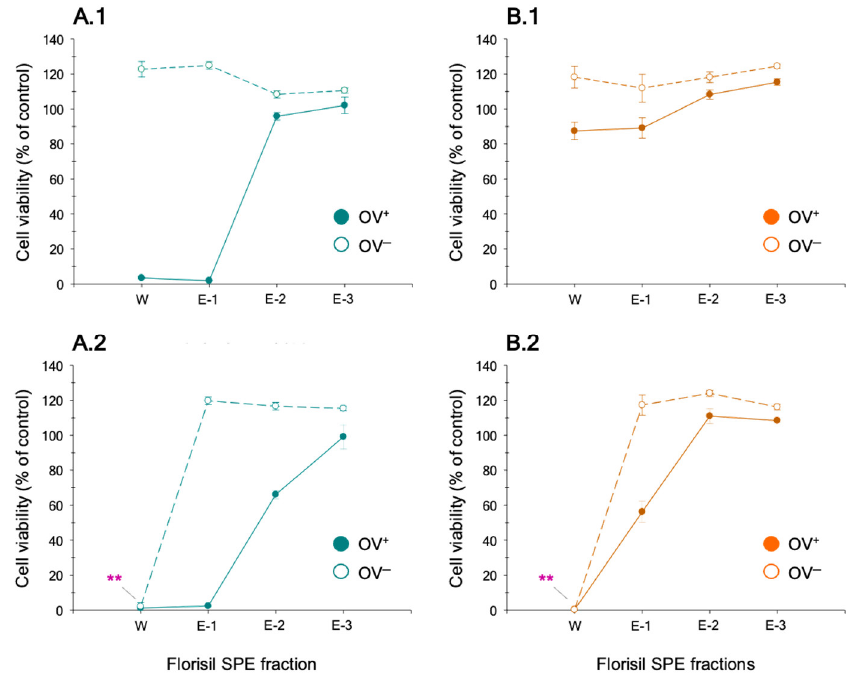
Figure 2. Example of the N2a toxicity profile of the fractions obtained from the Florisil SPE for a highly contaminated ( left ) and for a low toxic sample ( right ). Each fraction was analyzed at two concentration levels: ( A.1 , B.1 ): 44 mg TE·mL −1 (10 mg TE·well −1 ) and ( A.2 , B.2 ): 87 mg TE·mL −1 (20 mg TE·well −1 ). OV + : Sensitized cells; OV − : Non-sensitized cells. ** Florisil SPE fractions showing non-specific toxic effects.